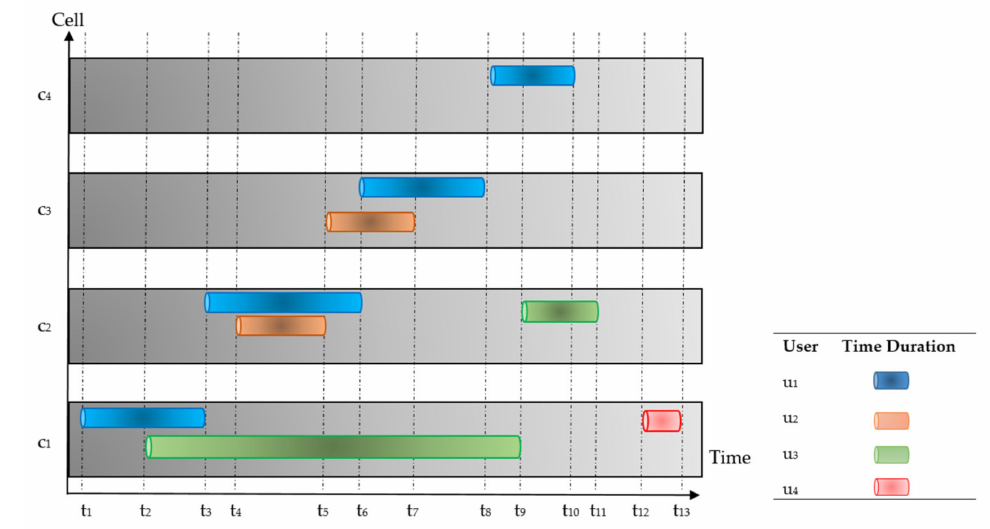
Figure 3. Spatiotemporal representation of semantic indoor movement trajectories of four